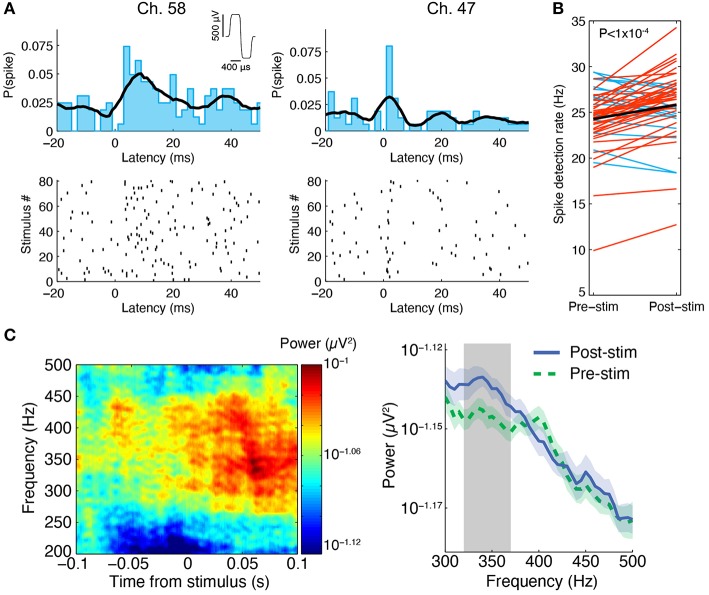
Stimulus-evoked spiking in perfused 3-D cell cultures at 6 DIV. (A) Spikes were evoked by electrical stimulation, the results from one experiment in a 3-D cell culture at six DIV are shown here. A stimulus was repeated at 0.83 Hz on a single electrode and it induced neuronal spiking recorded on multiple nearby electrodes, two of which are depicted here. Spikes are shown as black ticks in the raster plot. Each row of the plot represents a different stimulus delivery trial. The spiking probability (the probability of observing a spike at a given time) from 20 ms before to 50 ms after stimulus delivery is shown above the rastergram (2 ms bin width was used, the black curve is the histogram smoothed with a Gaussian, σ = 5 ms). The stimulus waveform was biphasic with 400 μs per phase at ± 500 mV levels (see inset at top). (B) Across all active sites in three separate perfused cultures, spike detection rates were higher after stimulation compared to pre-stimulation (paired t-test, P < 1 × 10−4, N = 51 sites pooled from three cultures). Red lines represent sites with increased spike detection rates, blue lines represent sites with decreased rates, and the black line represents the mean rate. (C) In the same experiment, we found that high-frequency activity between ~250 and 450 Hz was evoked by the stimuli. One example culture is shown here. Left: At an electrode 200 μm from the stimulus site, signal power around 350 Hz increased in the first 100 ms following stimulation (80 ms sliding window, 7 tapers). This can be seen by warm colors in the time-frequency representation of the signal power (μV2) on this electrode averaged over all stimulus deliveries. Right: Over all functional recording sites in one culture (N = 23 sites), there was a significant increase in signal power near 350 Hz in the first 100 ms after stimulus delivery compared to 100 ms pre stimulus delivery (100 ms sliding window, three tapers; Blue: mean ± SEM post-stimulus power; Green: mean ± SEM pre-stimulus power; Gray: frequency region of significant difference between the two conditions, P < 0.05).